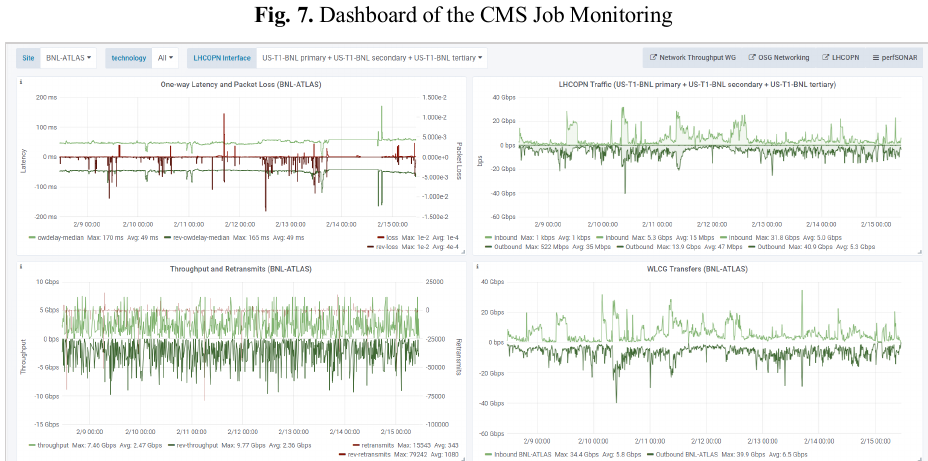
Fig. 8 Dashboard of the WLCG Network